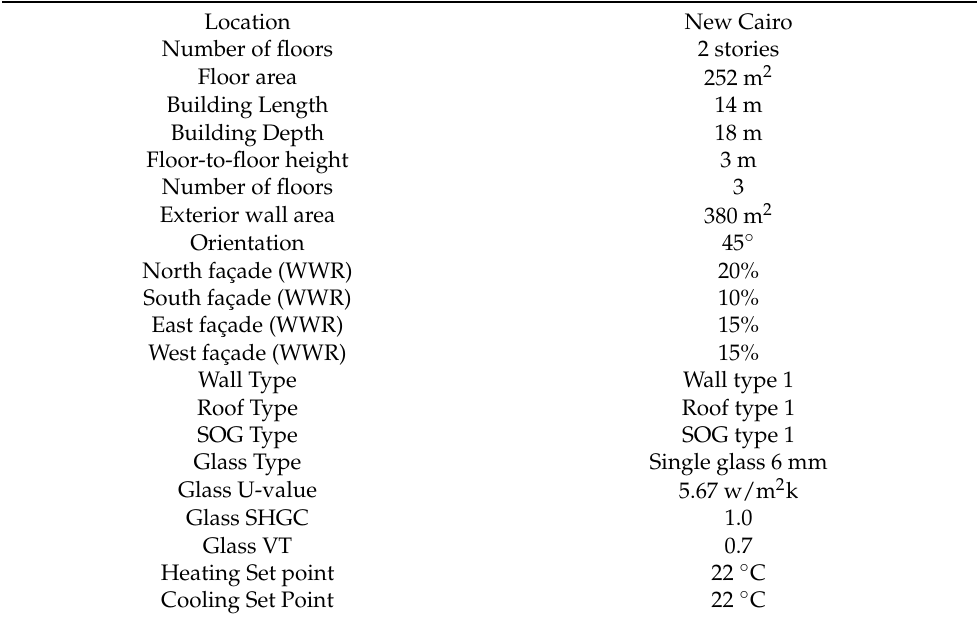
Table 4. Characteristics of the case study building.